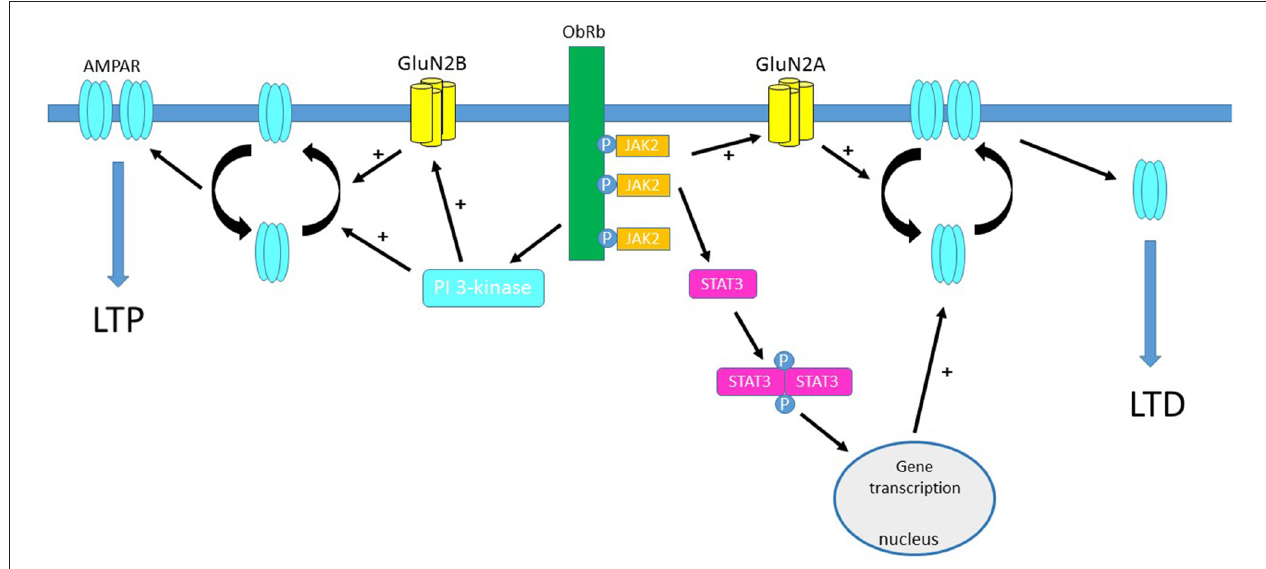
FIGURE 1 | Activation of leptin receptors influences hippocampal synaptic efficacy at temporoammonic (TA)-CA1 synapses. Schematic representation of the predominant signaling pathways that are activated by leptin receptors located at hippocampal TA-CA1 synapses. Leptin binding to ObRb results in phosphorylation of janus tyrosine kinase 2 (JAK2) which in turn promotes phosphorylation and dimerization of signal transducer and activator of transcription 3 (STAT3), leading to gene transcriptional changes in the nucleus. Activation of JAK2-STAT3 signaling mediates leptin-induced AMPA receptor internalization and induction of long-term depression (LTD) at adult TA-CA1 synapses. The ability of leptin to induce LTD at adult TA-CA1 synapses also requires the activation of GluN2A-containing NMDA receptors, which also promotes the removal of AMPA receptors from hippocampal synapses. In contrast, at juvenile TA-CA1 synapses, leptin-driven stimulation of the phosphoinositide-3 kinase (PI 3-kinase) cascade, culminates in the synaptic insertion of AMPA receptors and the induction of long-term potentiation (LTP). Activation of GluN2B NMDA receptor subunits is pivotal for leptin-induced LTP and the synaptic insertion of GluA2-lacking AMPA receptors at juvenile TA-CA1